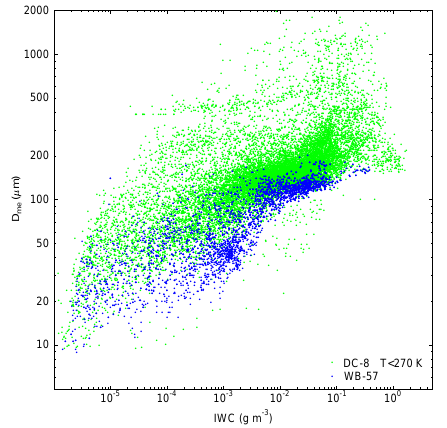
Fig. A2. Histograms of ice water content (IWC), IWC weighted mean equivalent sphere diameter ( D me ), and equivalent diameter ( D e ) dispersion from in situ cloud probes. The 2D-S&PIP size dis- tributions from the DC-8, the 2D-S size distributions from the WB- 57, and both combined are shown.